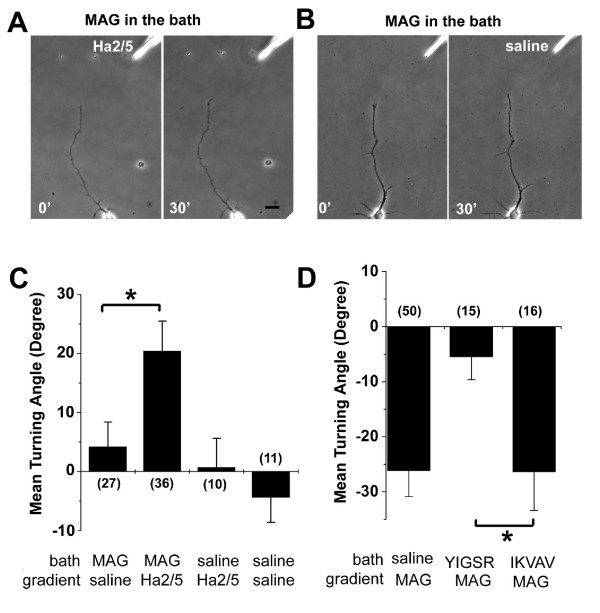
β1-integrin plays an instructive role in MAG-induced growth cone turning. A-C. Growth cone turning in the presence of uniform activation by MAG. Shown are sample images of growth cone turning of P5 rat hippocampal neuron axons in a gradient of Ha2/5 (0.5 mg/ml in the pipette, A) or saline (B) with uniform presence of MAG (150 ng/ml) in the bath. Scale bar: 20 μm. Also shown is the summary of growth cone turning angles under different conditions, C). Values represent mean ± s.e.m. Numbers associated with the bar graph indicate the number of growth cones analyzed. "*" indicates significant difference (p < 0.01, ANOVA). D. MAG-induced growth cone turning in the present of uniform activation of β1-integrin. Same as in (C), except that neurons were subjected to a MAG gradient (150 μg/ml in the pipette) with uniform presence of the β1-intergin activating peptide YIGSR (10 μg/ml), or the control peptide LKVAV (10 μg/ml), respectively.